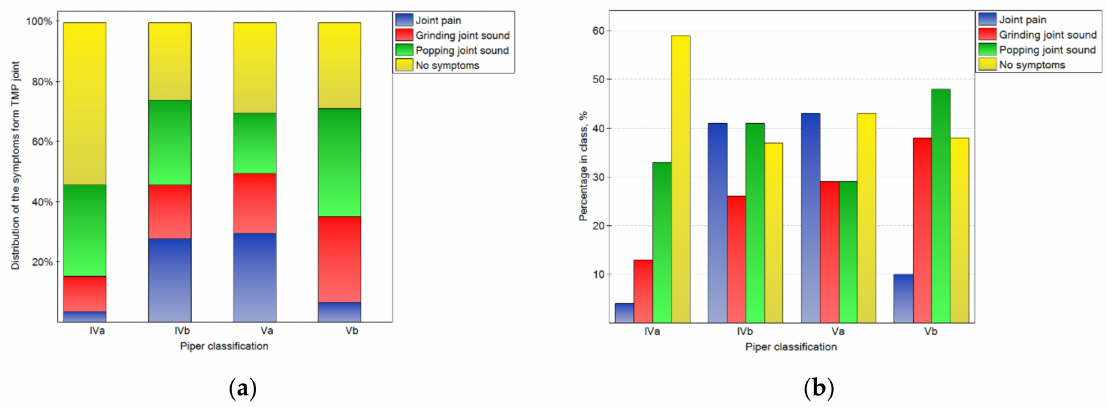
Figure 4. Impact of the Piper classification on the symptoms from TMJ: the distribution of symptoms among the classes ( a ), and the percentage of symptoms in the number of noted cases for the particular classes ( b